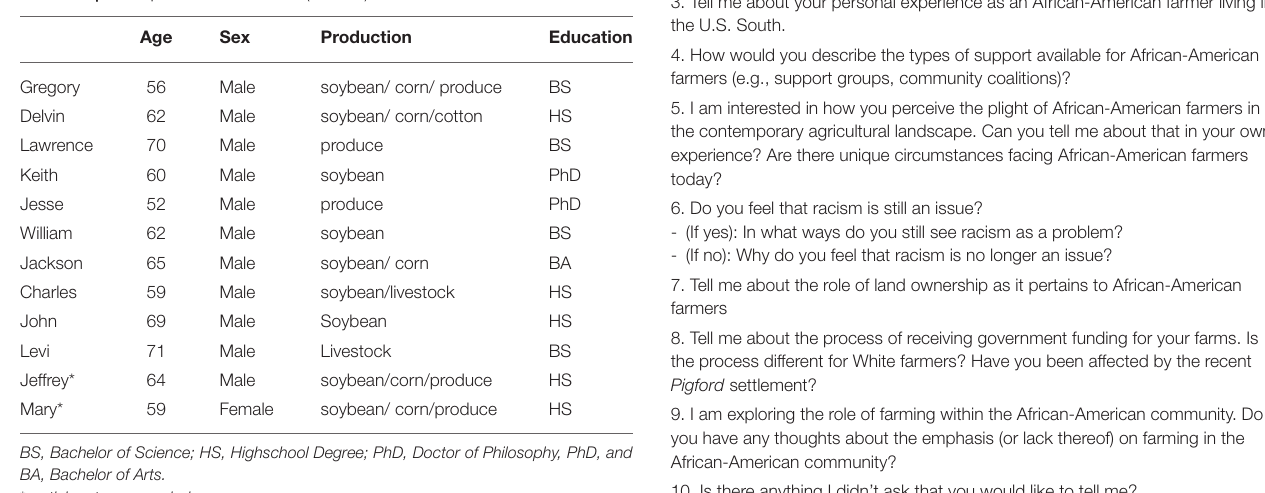
TABLE 1 | Participant Characteristics ( N = 11).